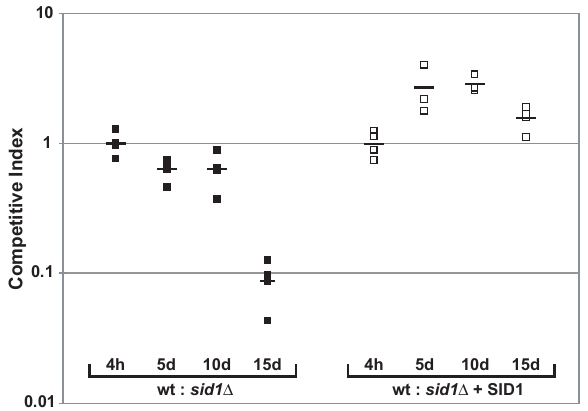
Figure 5. Disruption of SID1 Causes a Growth Defect in Mice. C57BL/6J mice were infected intranasally with an effective inoculum of 1 6 10 4 CFU of an equal mix of hcLH95 and hcLH97 (wt: sid1 D , black boxes) or hcLH95 and hcLH106 (wt: sid1 D + SID1 , white boxes). Boxes indicate the competitive index (CI) for individual mice as determined in Materials and Methods. Horizontal bars indicate the means of CI values. A pairwise comparison of the 15-day CI for the wt: sid1 D and wt: sid1 D + SID1 infections by the Mann-Whitney/Wilcoxon test revealed that they were significantly different (p=0.0286). Significance for WT: sid1 D time course was determined using Kruskal-Wallis test (ANOVA) with Dunn’s Multiple Comparisons test. This analysis showed that the CI at t=4 hr and t=15 days was significantly different (p ,